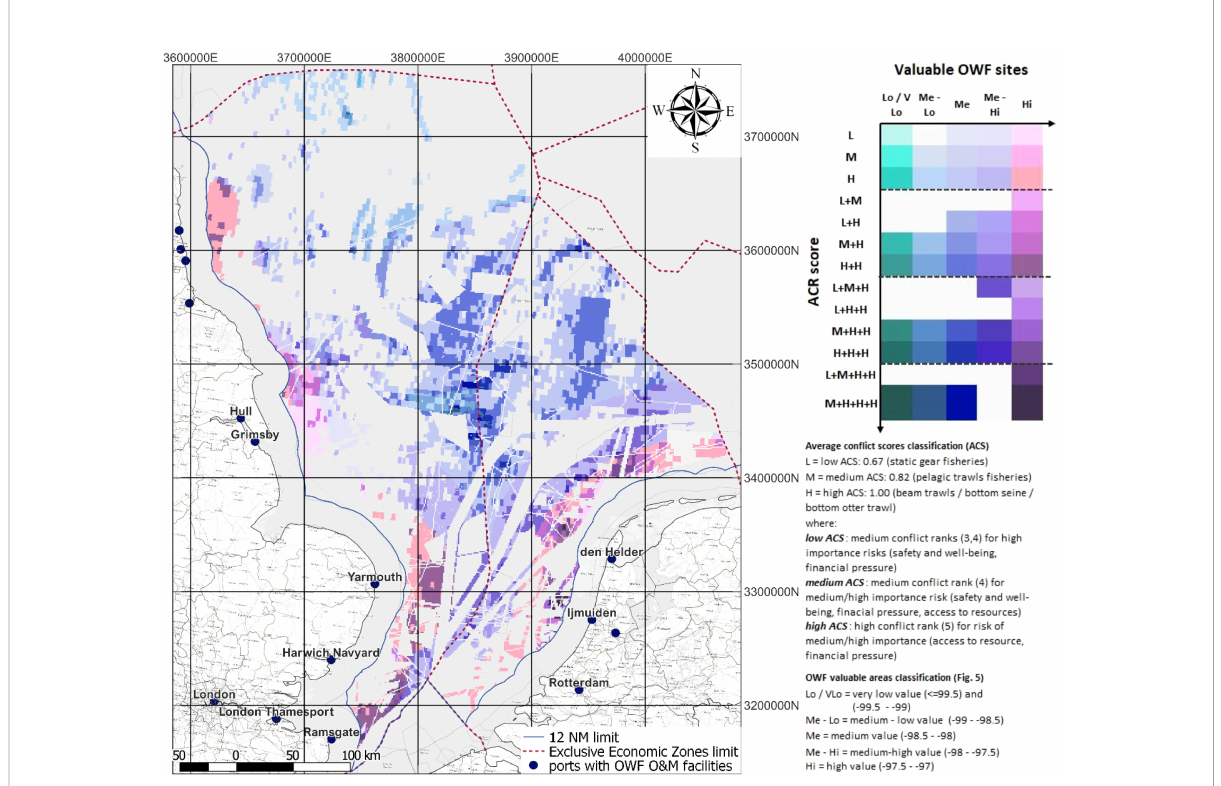
FIGURE 13 Average con fl ict resolution scores for the interaction between OWFs and high intensity fi shing